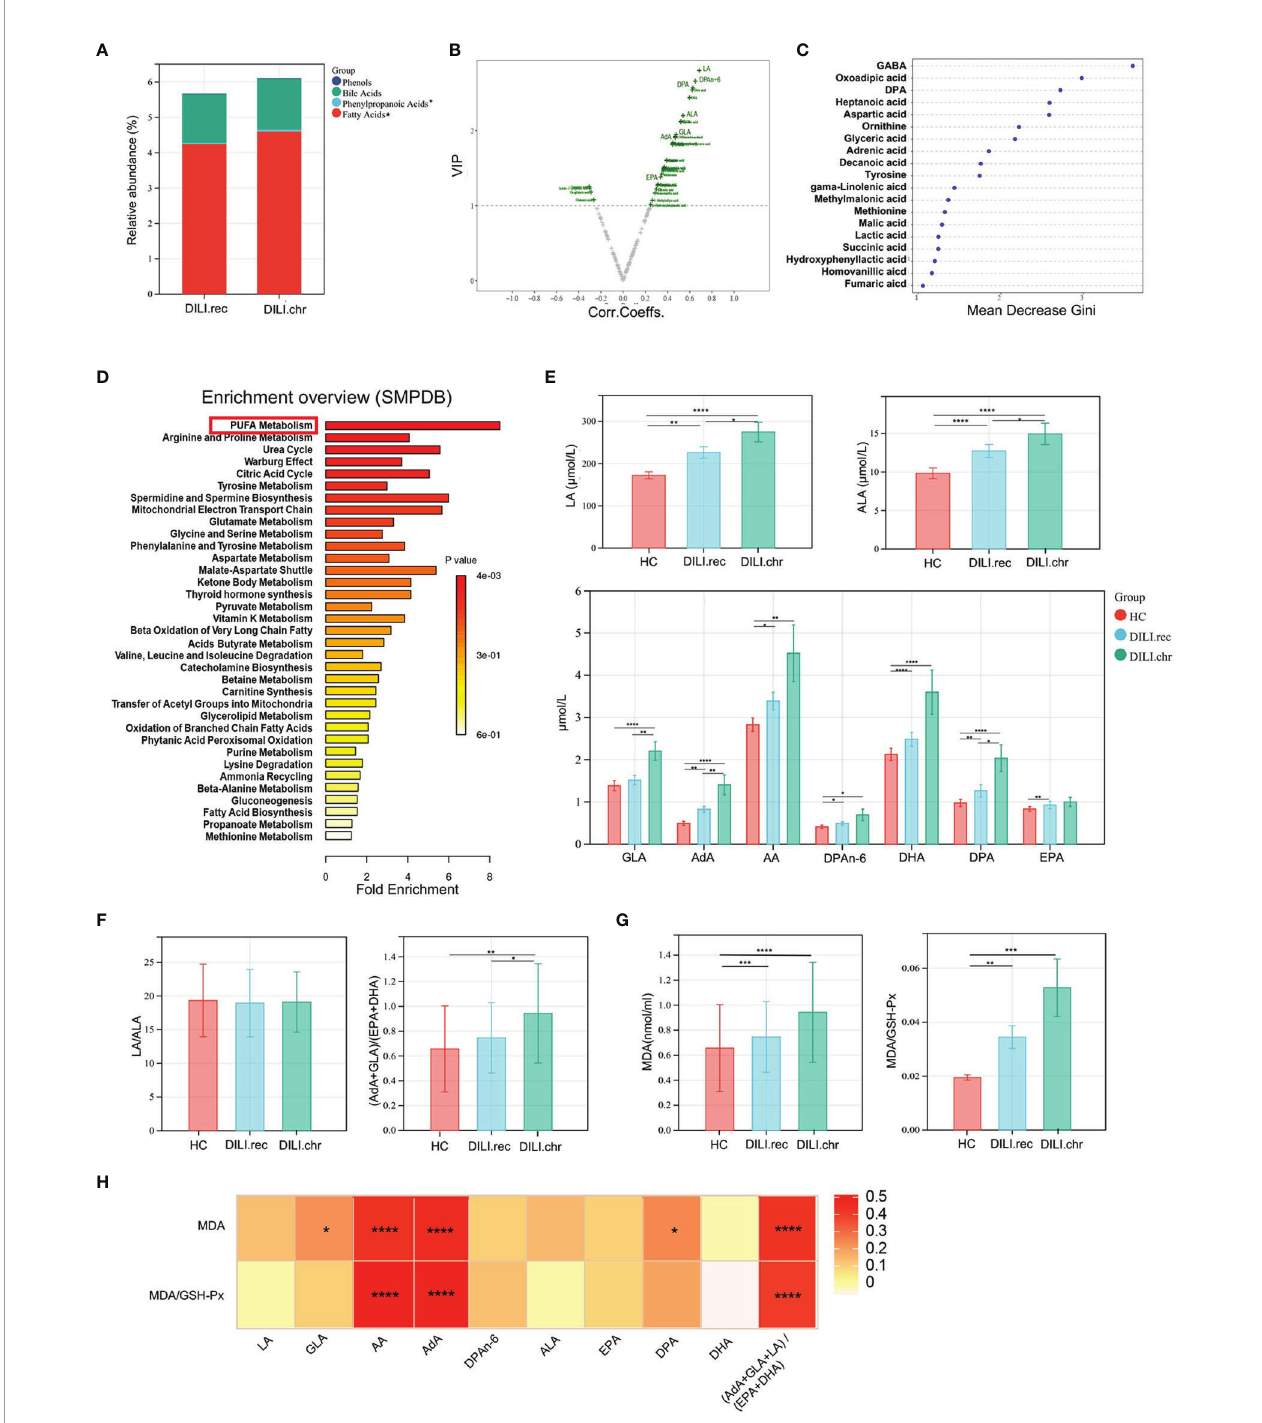
FIGURE 4 | PUFAs were correlated with the chronicity of DILI. (A) The relative abundance of altered metabolite classes in recovered DILI (DILI.rec) and chronic DILI (DILI.chr) group. (B) Volcono plot of the most signi fi cant metabolite changes comparing DILI.rec with DILI.chr group. (C) Importance scores of top 20 important differential metabolites by RF between DILI.chr and DILI.rec. (D) A pathway analysis used to discover the different metabolic characteristics between DILI.rec and DILI.chr (based on SMPDB). (E) Boxplot of omega-6 PUFAs in HCs, DILI.rec and DILI.chr groups. (F) The ratios of LA/ALA and (AdA+GLA)/(EPA+DHA) between HC, DILI.rec and DILI.chr groups. (G) Serum levels of MDA and MDA/GSH-Px in HC, DILI.rec and DILI.chr groups. (H) Correlations of PUFAs with MDA and MDA/GSH- Px. *p < 0.05; **p < 0.01; ***p < 0.001; ****p < 0.0001. EPA, eicosapentaenoic acid; DHA, docosahexaenoic